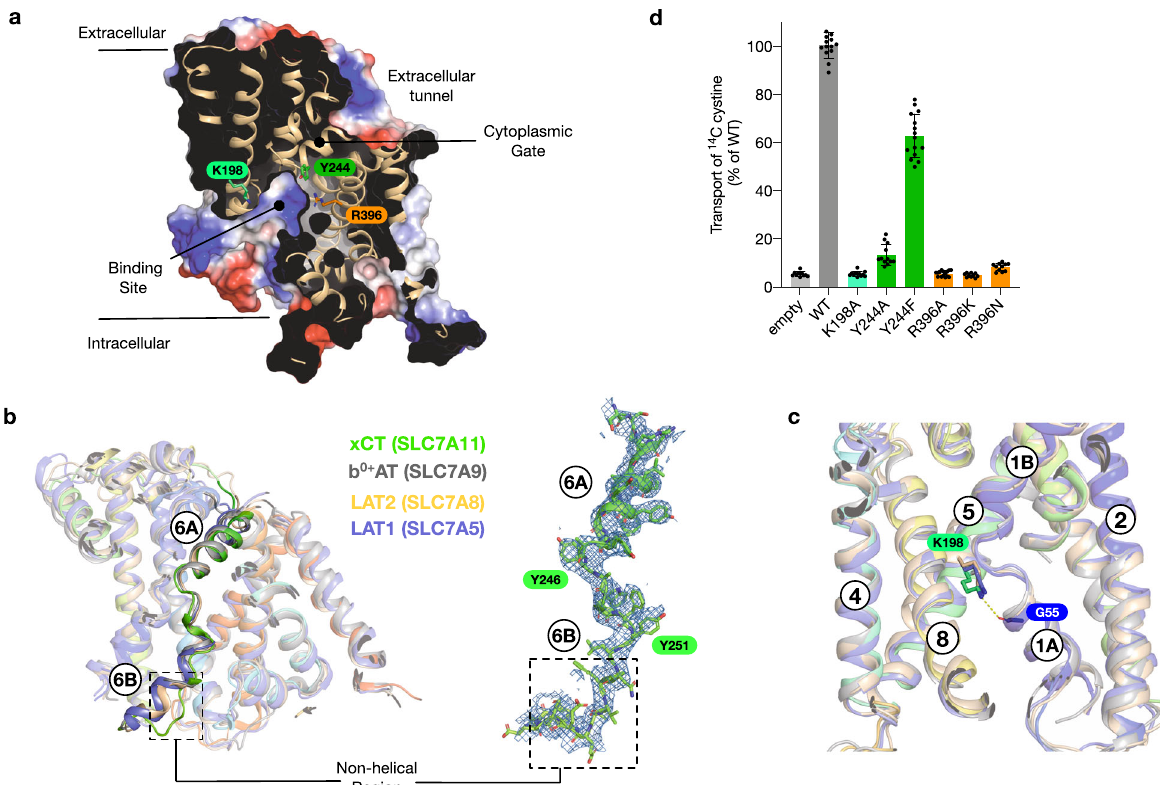
Fig. 2 Binding site architecture of xCT. a Electrostatic surface representation highlighting the binding site and key residues. b Structural overlay of human SLC7 transporter structures highlighting TM6A and TM6B. The cryo-EM coulombic density for TM6 is shown (blue mesh) for xCT (this study), contoured at 8 sigma. The structural overlay consists of b 0 + , AT (PDB:6lid), xCT (this study), LAT1 (PDB:6irt) and LAT2 (PDB:7cmi). c zoomed in view of the interaction between K198 on TM5 and G55 on TM1A in xCT, overlaid are the conserved lysine positions in b 0 + , AT, LAT1 and LAT2, as in b . d Transport assays of cystine uptake for cells transfected with a plasmid containing wild type or variant forms of SLC7A11 or the empty plasmid as a negative control. n = 12 independent experiments, data are presented as mean values and error bars